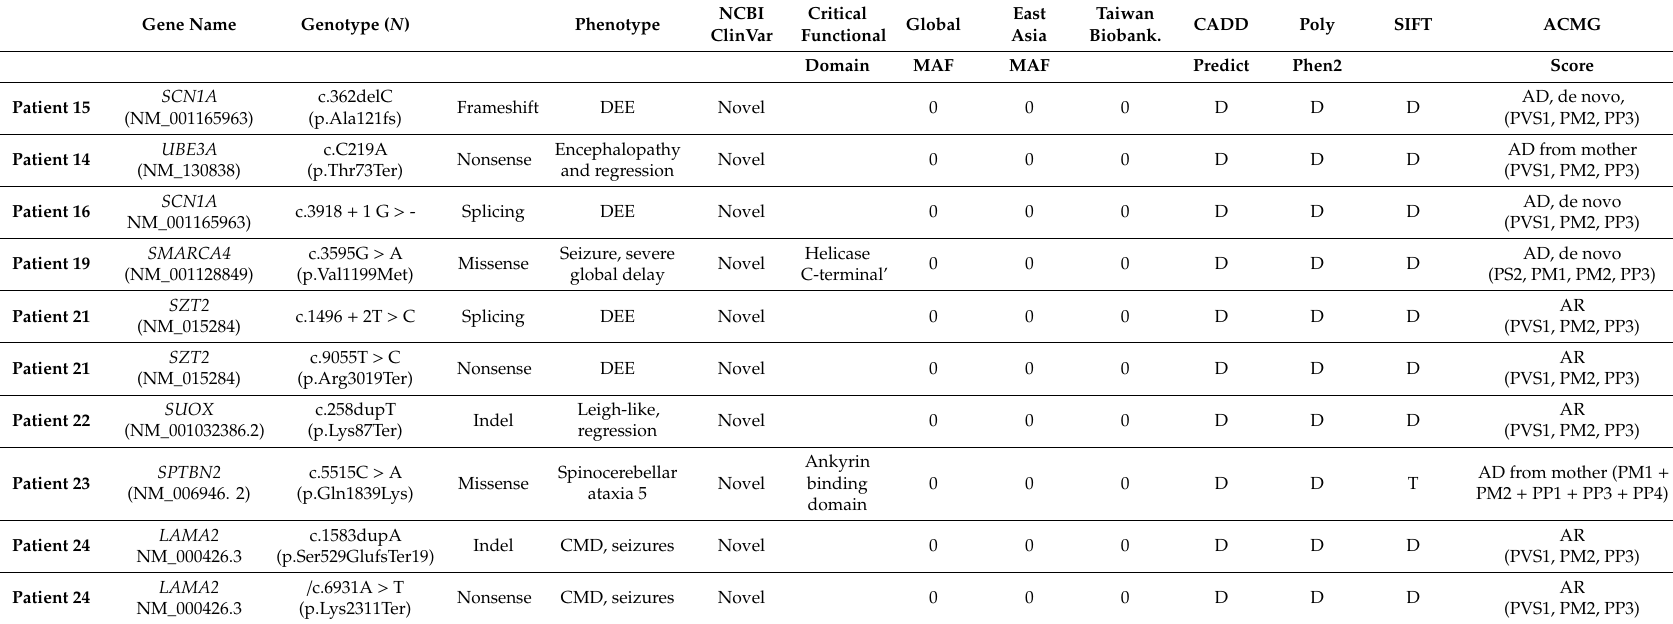
Table 3. Ten novel mutations in the